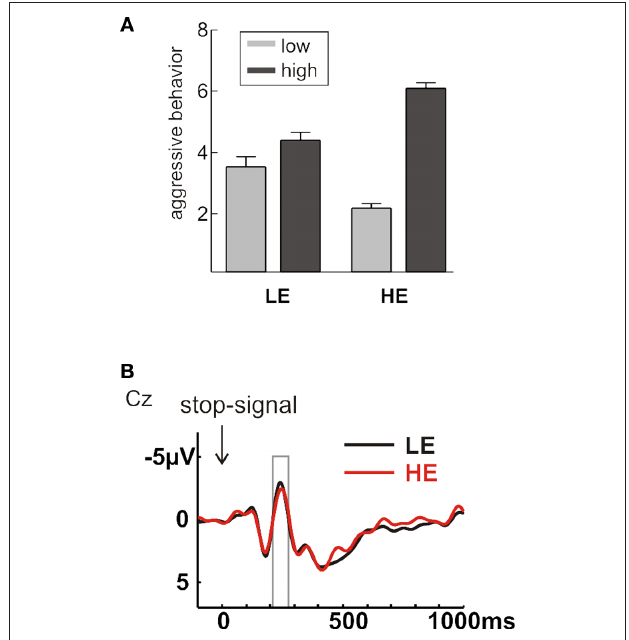
FiguRE 2 | (A) Depicted are the mean selections under low (light gray) and high (dark gray) provocation separately for the two groups LE (low experimentally induced aggression) and HE (high experimentally induced aggression; right panel) in the Taylor Aggression Paradigm. Error bars reflect SE. (B) Event-related potentials (ERPs), stimulus-locked to the stop-stimulus in successfully inhibited trials, separately for the groups LE (black line) and HE (red line). The time-window of interest for the stop-N2 (200–280 ms) is indicated with a gray box.